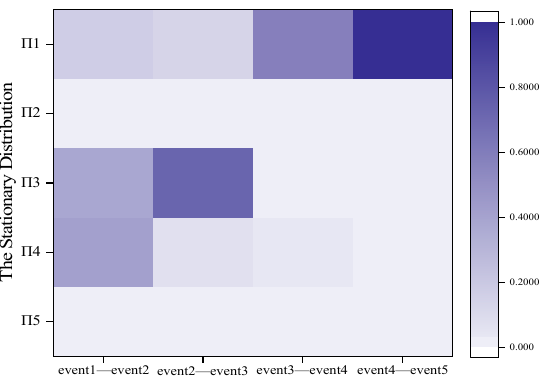
Figure 4. Stationary distribution of occupant between adjacent events.